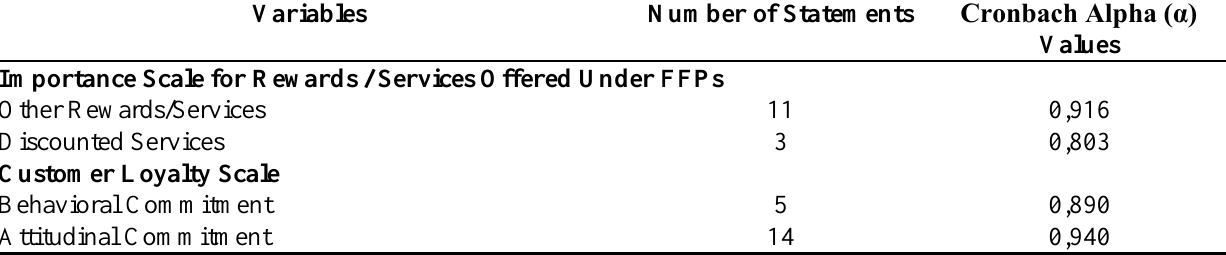
Table 6. Reliability analysis of